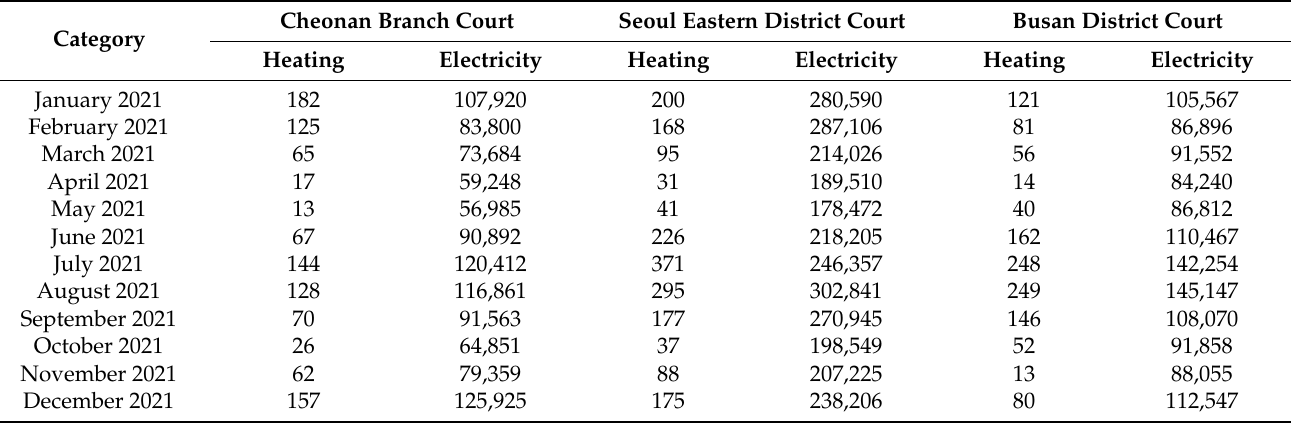
Table 5. Collected energy consumption data (G-SEED certified and before insulation thickness standard revision).